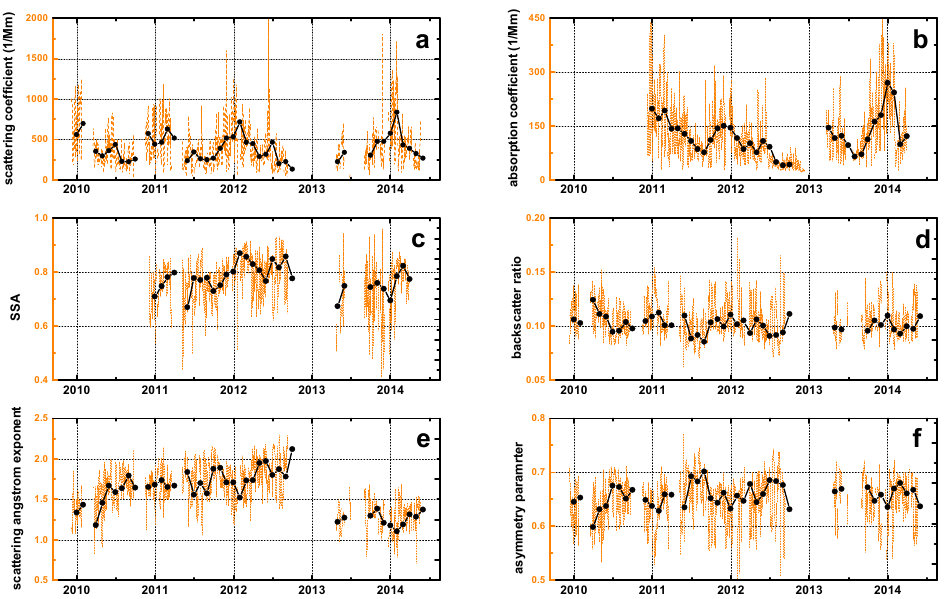
Figure 3. The temporal series of hourly average aerosol optical properties. Black dotted lines represent the monthly mean values. Where ( a ) scattering coe ffi cient (Mm − 1 ), ( b ) absorption coe ffi cient (Mm − 1 ), ( c ) SSA, ( d ) backscatter ratio, ( e ) scattering Ångström index, ( f ) asymmetry parameter. Significant seasonal variations can be found for all the aerosol optical